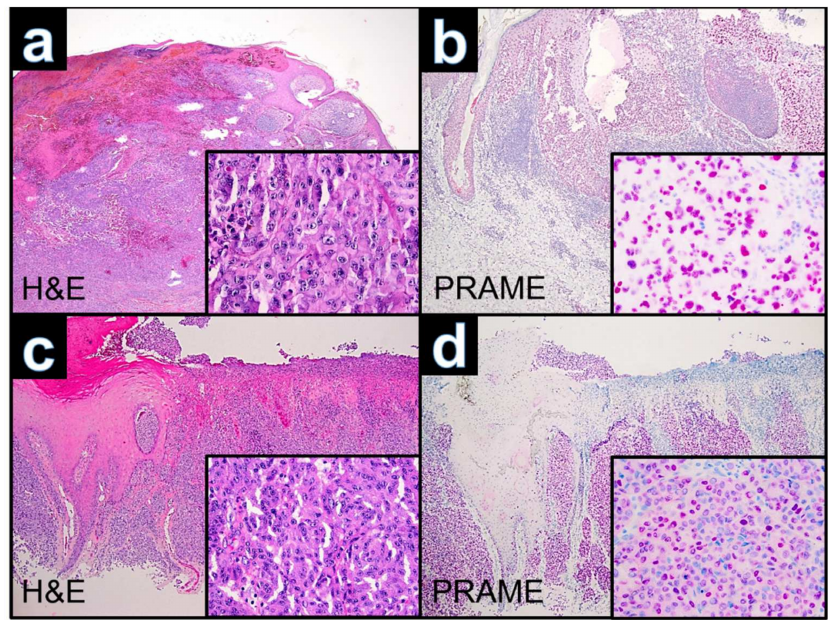
Figure 3. ( a ): Case WUE1: Ulcerated polypoid tumor of a 74 year old patient from the chest (H&E × 40). Inset H&E × 400. ( c ): Case WUE2: Ulcerated tumor of a 72 year old patient from the ankle (HE × 40). Inset HE × 400. ( b,d ): Cases WUE1 and WUE2: The tumor cells are diffusely positive for PRAME (nuclear labeling) (PRAME × 40). Inset highlights that PRAME labeling is nuclear (PRAME ×